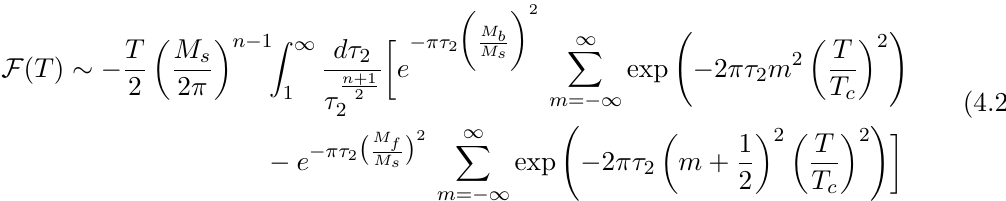
. Choice of parameters: m 0